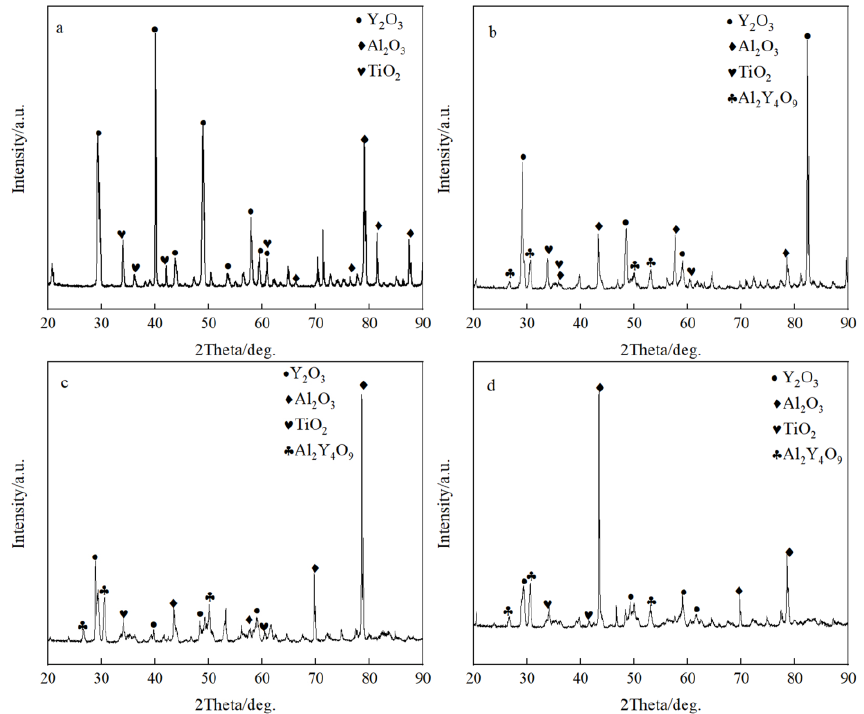
Figure 4. The XRD spectrum of the interface. ( a – d ) represent the pure Y 2 O 3 , Al 2 O 3 -A, Al 2 O 3 -B and Al 2 O 3 -C crucibles, respectively.